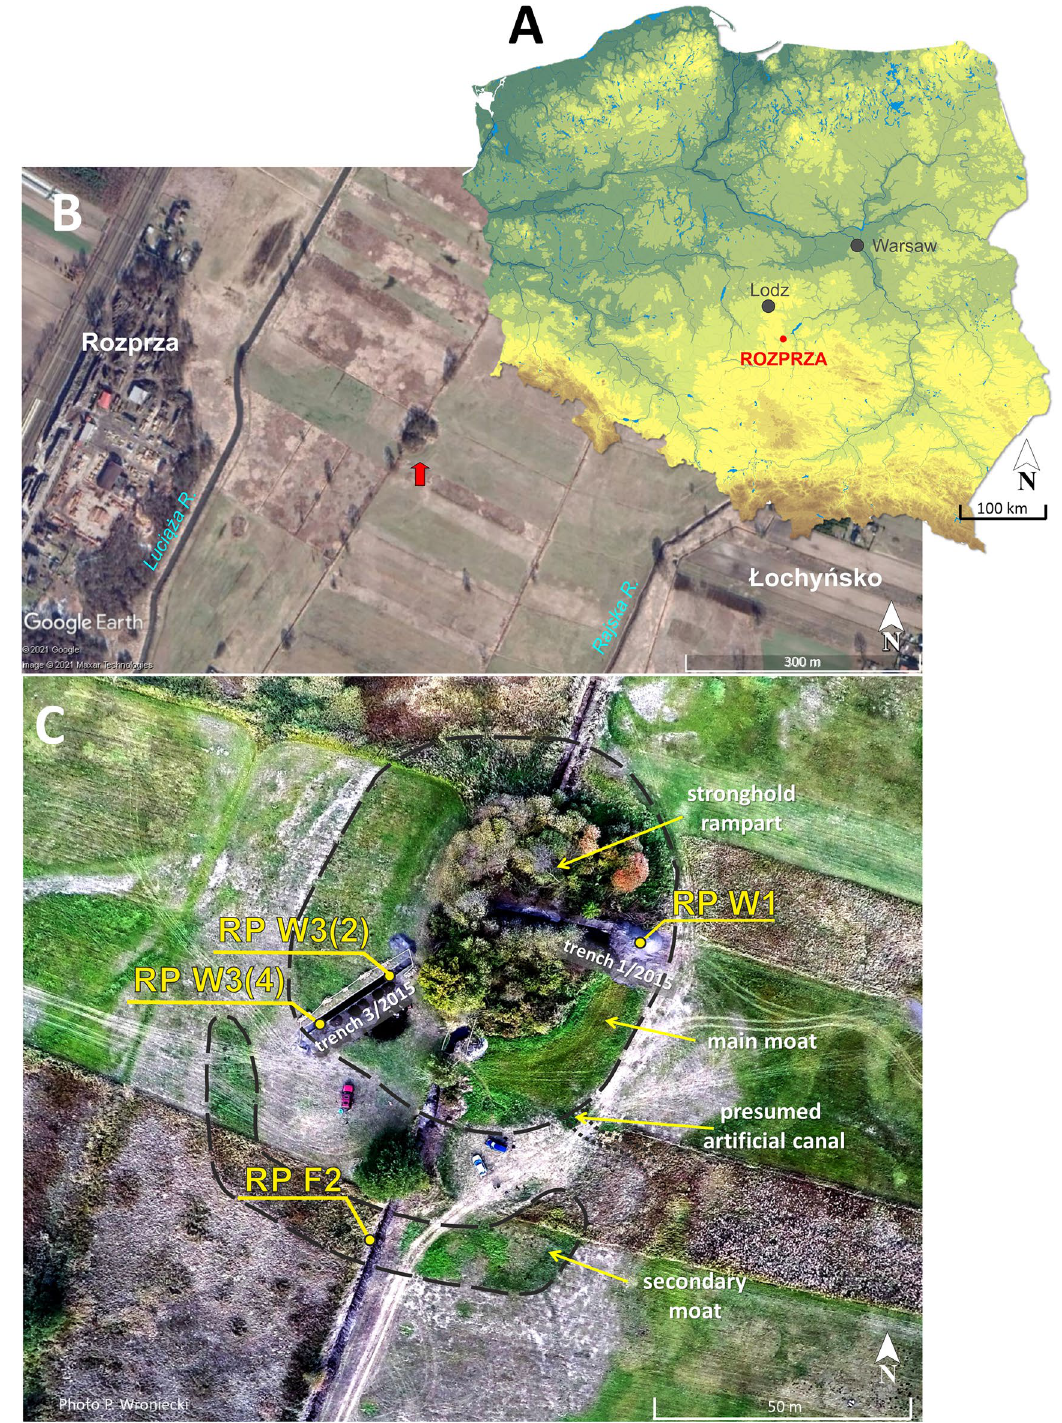
Figure 1. ( A ) Study site location in the territory of Poland. ( B ) The satellite picture of the contemporary surroundings of the study area. The red arrow indicates the stronghold’s remnants (source: Google Earth, modified). ( C ) Aerial photo of the study area. The locations of the studied profiles (cores) are marked by yellow dots. Arrows indicate the traces of artificial elements visible in the terrain relief—moats (dashed lines) and presumed artificial canal (dotted lines) (photo: P. Wroniecki,